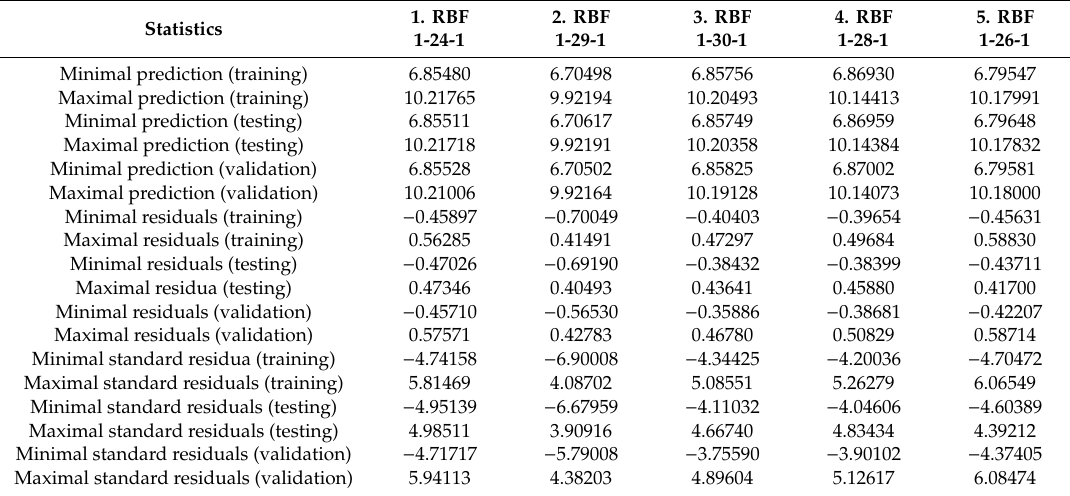
Table 4. Statistics of individual data sets by retained neural